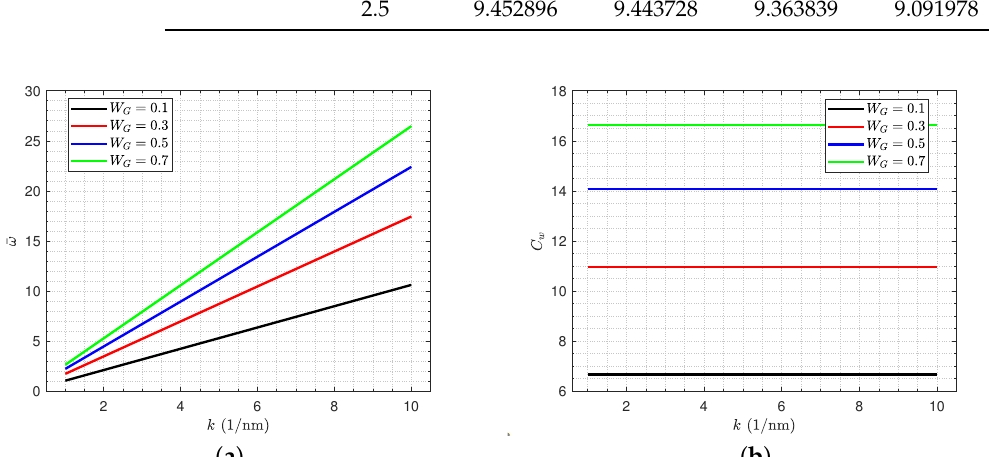
Figure 4. Influences of the wave number k and the graphene weight fraction W G on ( a ) the wave frequency ¯ ω (THz) and ( b ) phase velocity C w (km/s) of the FG GPLs-reinforced sandwich nanocom- posite piezoelectromagnetic plates with honeycomb